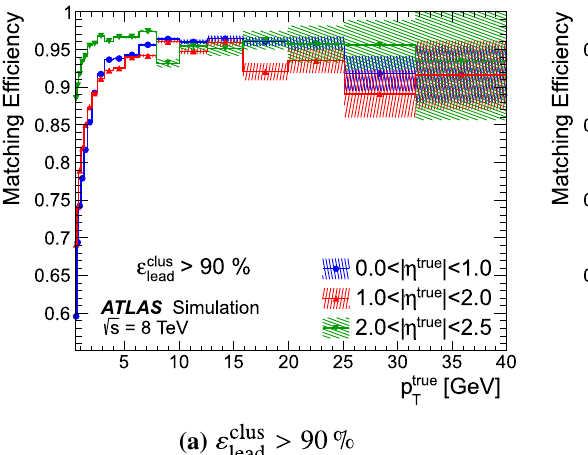
from a dijet sample without pile-up with 20 < p lead the statistical uncertainties on the number of MC simulated events are shown as a hatched band